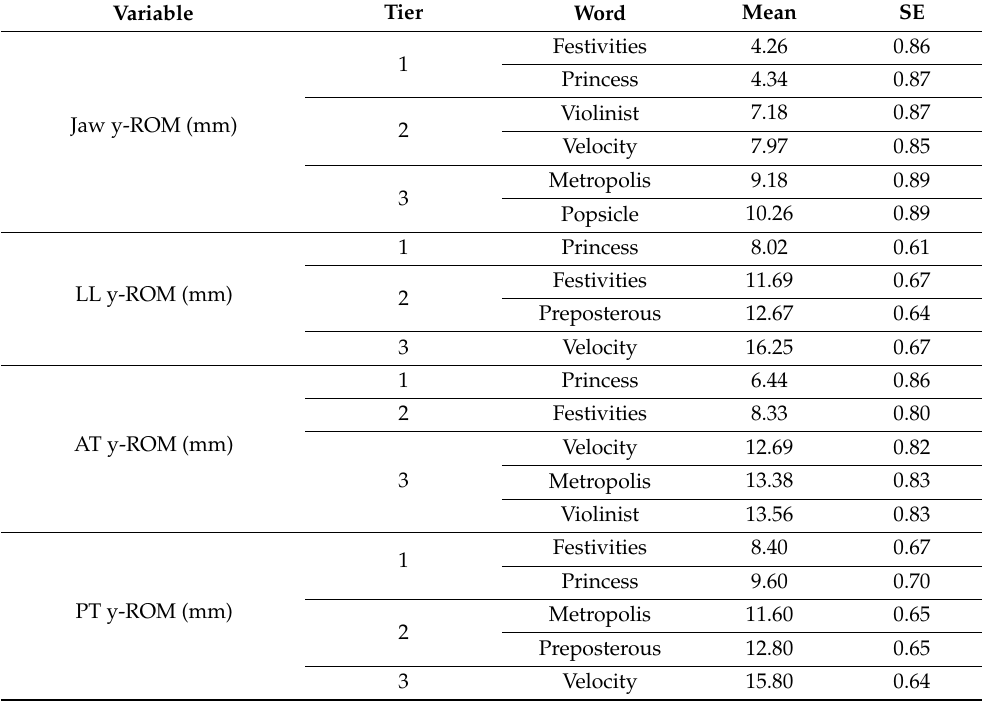
Table 2. Control group’s ROM means for speech stimuli in their respective range of motion (ROM) demand tiers.